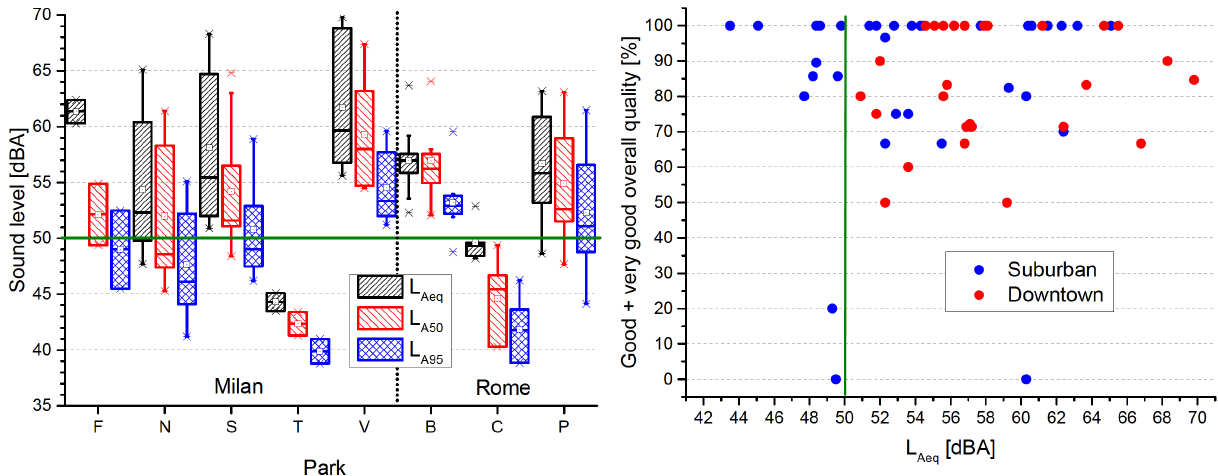
Figure 6: Percentage of respondents rating the overall quality of the park either good or very good versus the corresponding L Aeq .